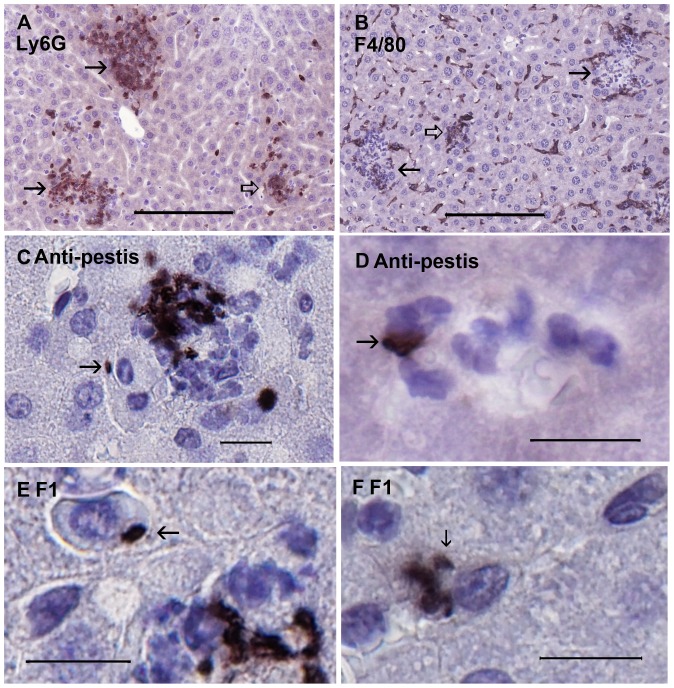
Early in infection many Y. pestis KIM5 bacteria were associated with inflammatory cells including PMNs.Mice were infected IV for 17 h with 107 28/37°C-grown Y. pestis KIM5. Sections of formalin-fixed paraffin-embedded livers were stained with cell- or Y. pestis-specific antibody, developed with DAB (black or brown), and counterstained with hematoxylin. Antibodies used were: Panel A, anti-Ly6G (for PMNs); Panel B, anti-F4/80 (for KCs and MOs); Panels C and D, anti-Y. pestis antibodies; Panels E and F, the YPF19 monoclonal antibody against the F1 fibril. Solid arrows in panels A and B indicate foci of inflammation; open arrows indicate either small foci or “polar cap” (tangential) sections of foci. The arrow in panel C points to a bacterium on a mononuclear cell adjacent to a focus where numerous bacteria were contained in the plane of the section. The arrow in panel D indicates several bacteria associated with PMNs in a hepatic sinus. Arrows in panels E and F point to bacteria associated with mononuclear cells. The bars in panels A and B represent 100 µm; in panels C-F, the bars represent 10 µm.